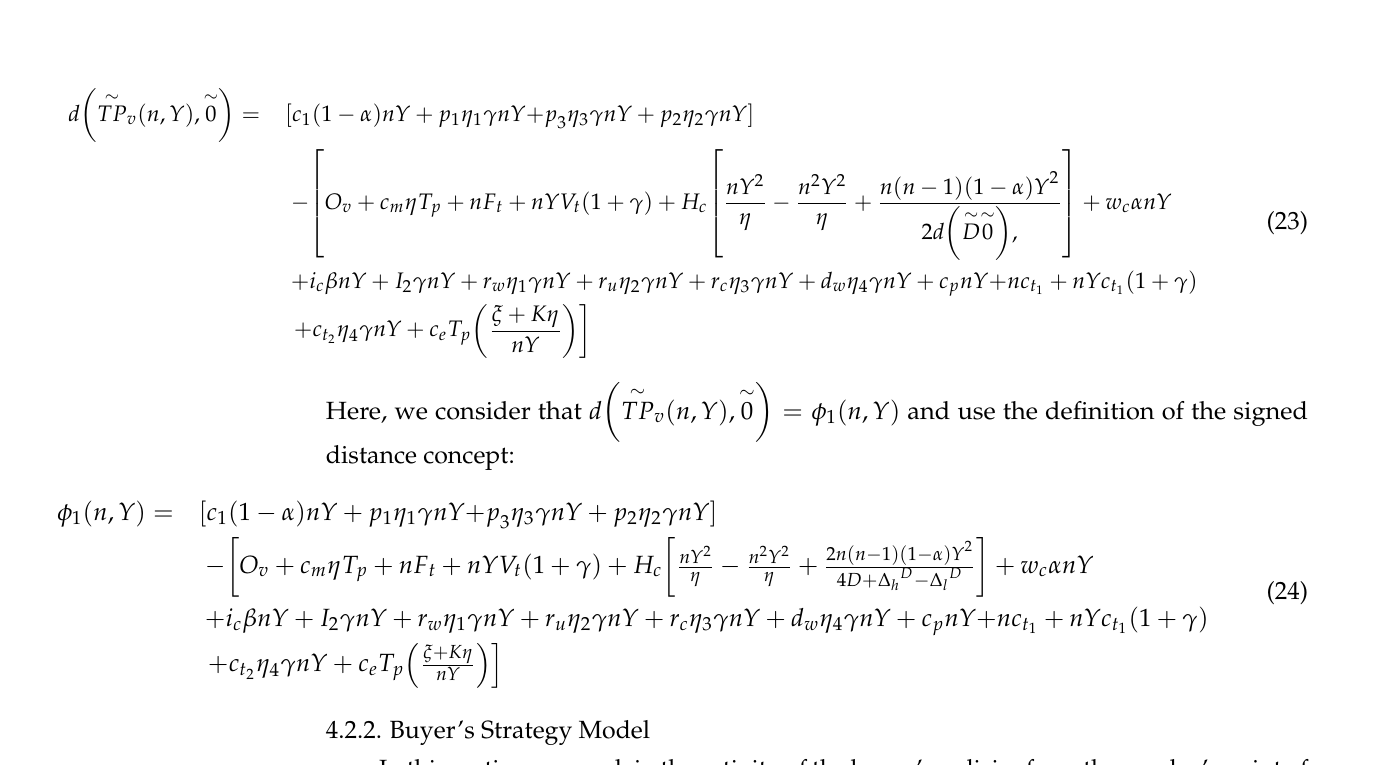
Figure 8. Buyer’s inventory representation for n th cycle. The screening time is given as: